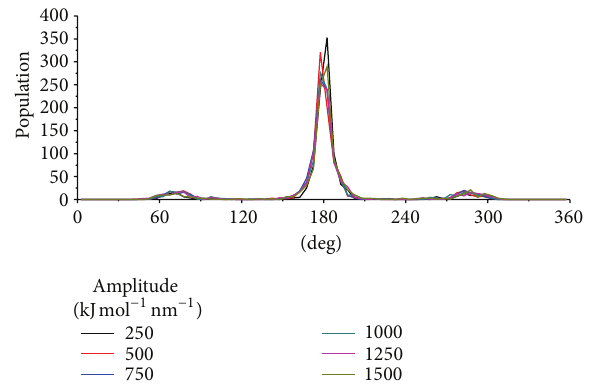
Figure 12: The torsion distributions of the final structures derived from the VEMD simulations with varied